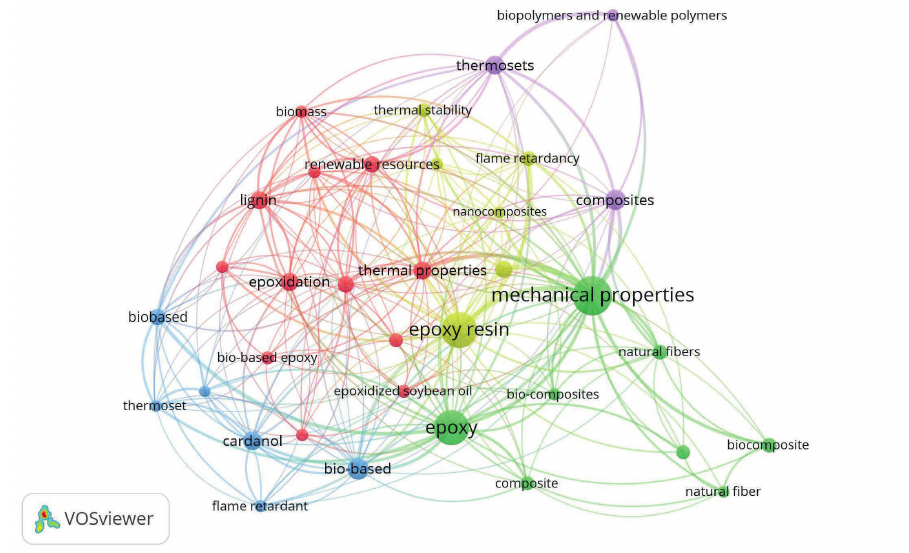
Fig. 5. Keyword co-occurrence in journal articles on topic of biobased